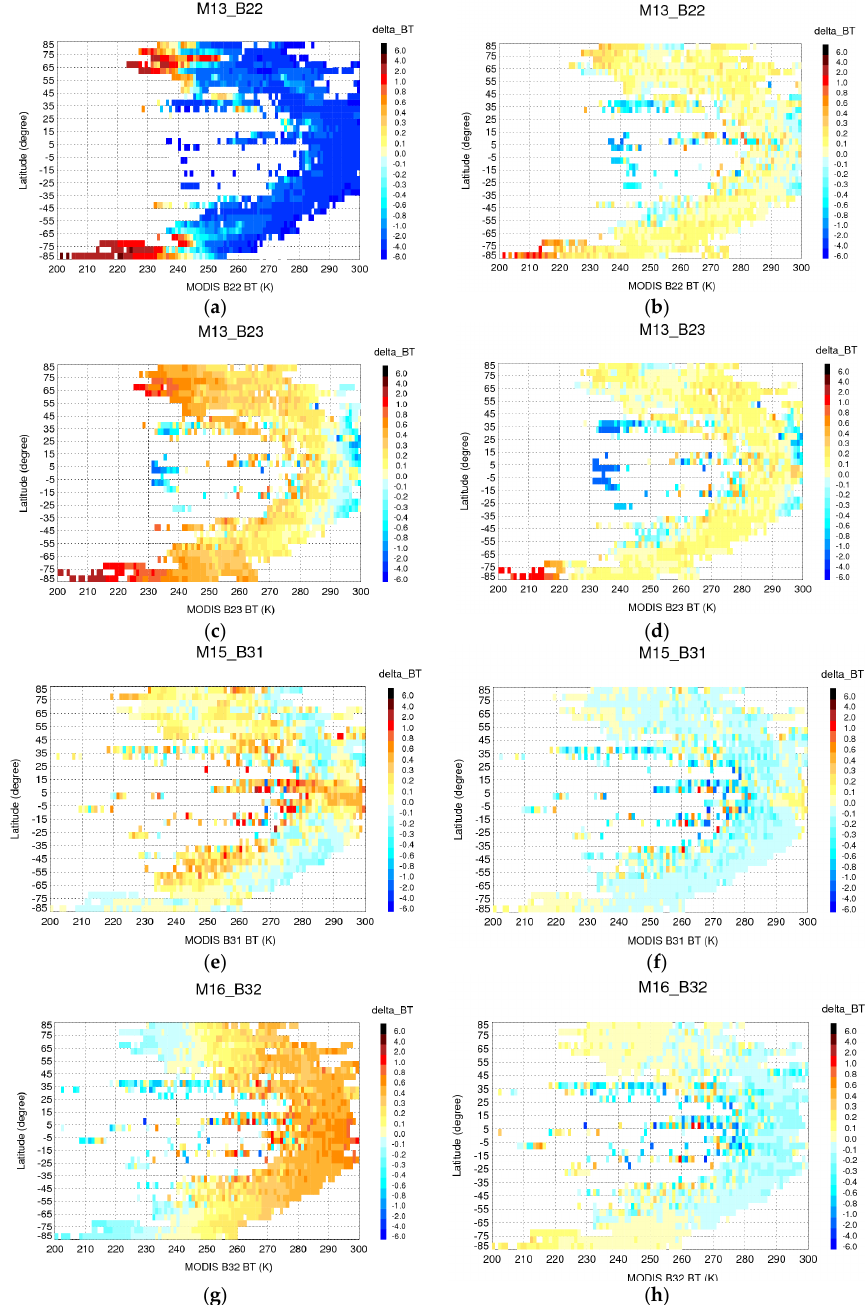
Figure 3. Distribution of VIIRS-MODIS inter-comparison without/with RSR correction from AIRS measurements. ( a ) M13_B22 without RSR correction; ( b ) M13_B22 with RSR correction; ( c ) M13_B23 without RSR correction; ( d ) M13_B23 with RSR correction; ( e ) M15_B31 without RSR correction; ( f ) M15_B31 with RSR correction; ( g ) M16_B32 without RSR correction; ( h ) M16_B32 with RSR correction.